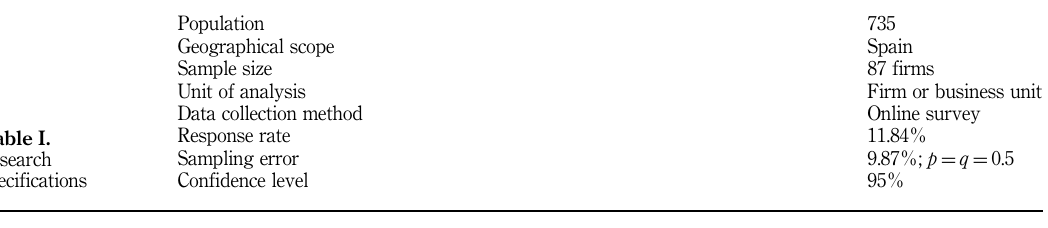
Table II. T -test for means equality when equal variances are